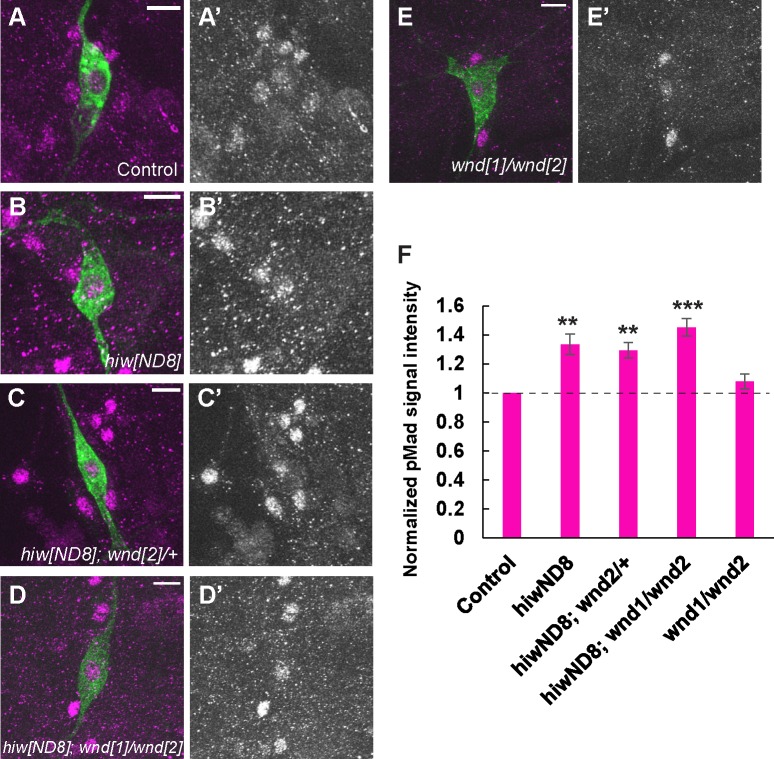
Activated BMP signaling in hiw mutant does not depend on wallenda.(A-E) Representative images of pMad immunoreactivity in nociceptor soma. Green shows mCD8::GFP and magenta represents pMad signals. (A’-E’) Split images for pMad signals. Scale bars represent 10 μm. (F) Quantification of nuclear pMad signals in nociceptors. Similarly to hiwND8 mutants (hiwND8; ppk-GAL4 UAS-mCD8::GFP/+, n = 36), hiwND8 with heterozygous or transheterozygous wnd mutations (hiwND8; ppk-GAL4 UAS-mCD8::GFP/+; wnd2/+ and hiwND8; ppk-GAL4 UAS-mCD8::GFP/+; wnd1/wnd2, n = 48 and 45) showed significantly increased nuclear pMad level relative to controls (ppk-GAL4 UAS-mCD8::GFP/+, n = 48). The transheterozygous wnd mutants (ppk-GAL4 UAS-mCD8::GFP/+; wnd1/wnd2, n = 33) did not show a significant difference in nuclear pMad level compared to controls (p > 0.7). ** p < 0.01, *** p < 0.001 (Mann-Whitney’s U-test). Error bars represent standard error.